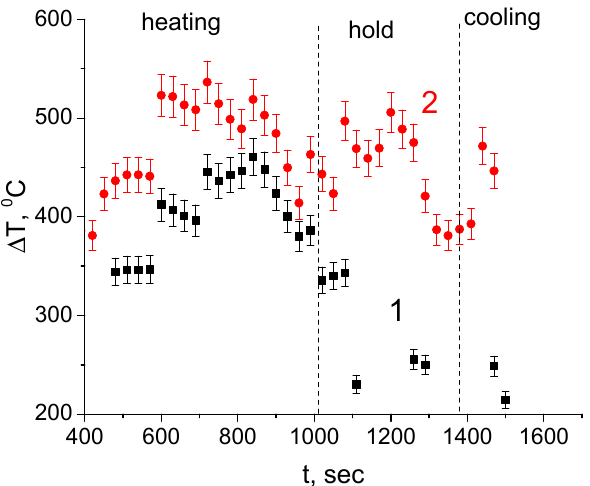
Figure 2. Time dependence of the temperature drop across different ceramics: 1—Al 2 O 3 , 2—ZrO 2 . As seen from these dependencies, the maximum temperature drop ∆ T occurs during the initial stage of sample heating. As expected, the temperature drop for zirconia ceramic is greater by more than 100 ◦ C than for alumina ceramic due to the lower coefficient of thermal conductivity of zirconia. The maximum value of ∆ T for zirconia ceramic reached 500–550 ◦ C during heating and fell to 400–450 ◦ C during holding and cooling.